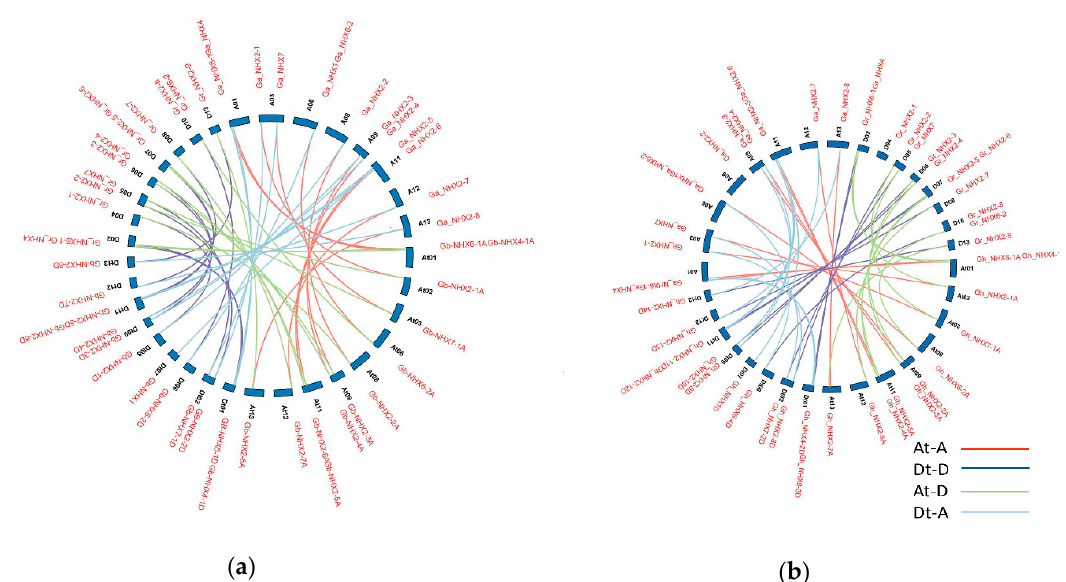
Figure 4. Collinearity analysis of G. barbadense ( a ) and G. hirsutum ( b ) (A and D) orthologs in the G. arboreum (A Chr) and G. raimondii (D Chr) genomes. Orthologs are connected by colored lines. Table 3. Orthologous and paralogous gene pairs for Gb and Gh.